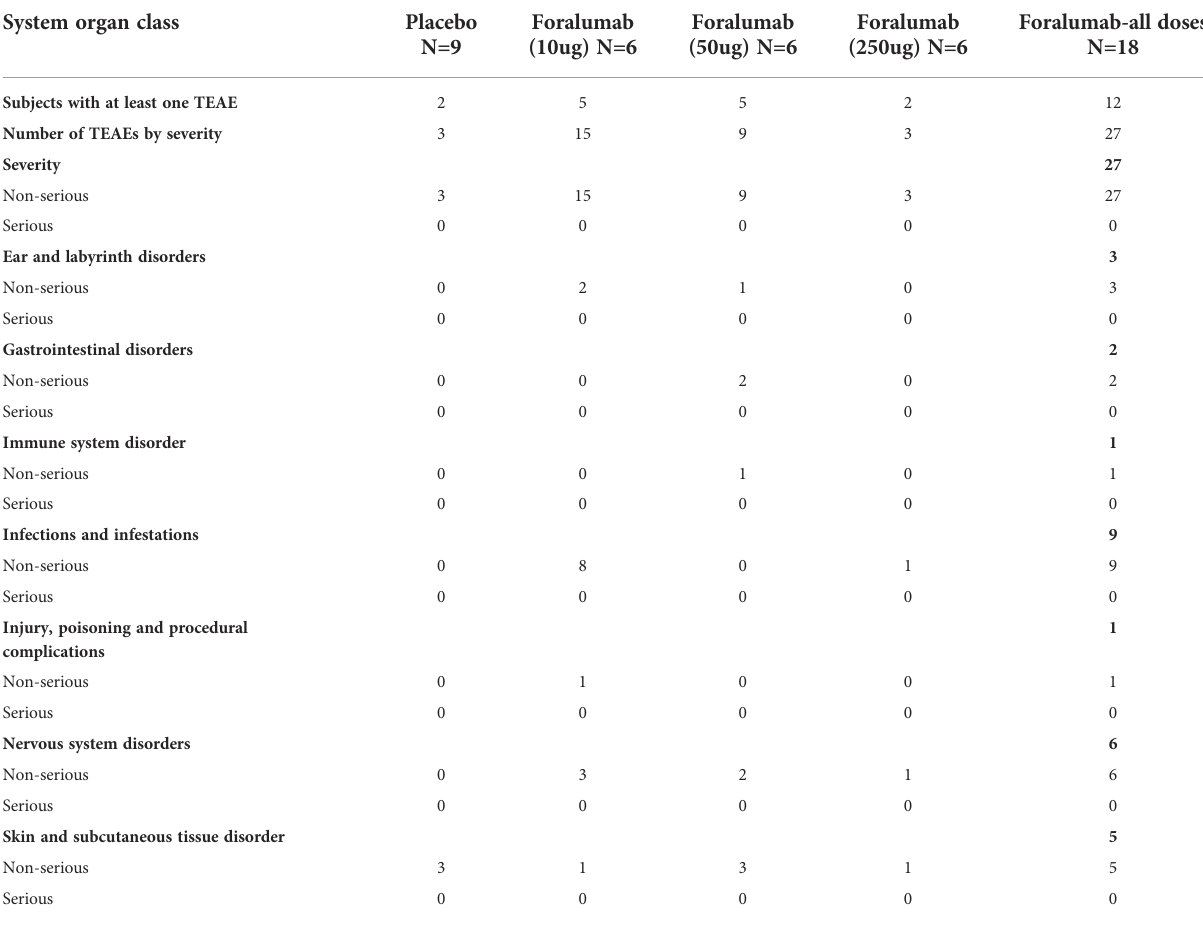
TABLE 2 Treatment-emergent adverse event